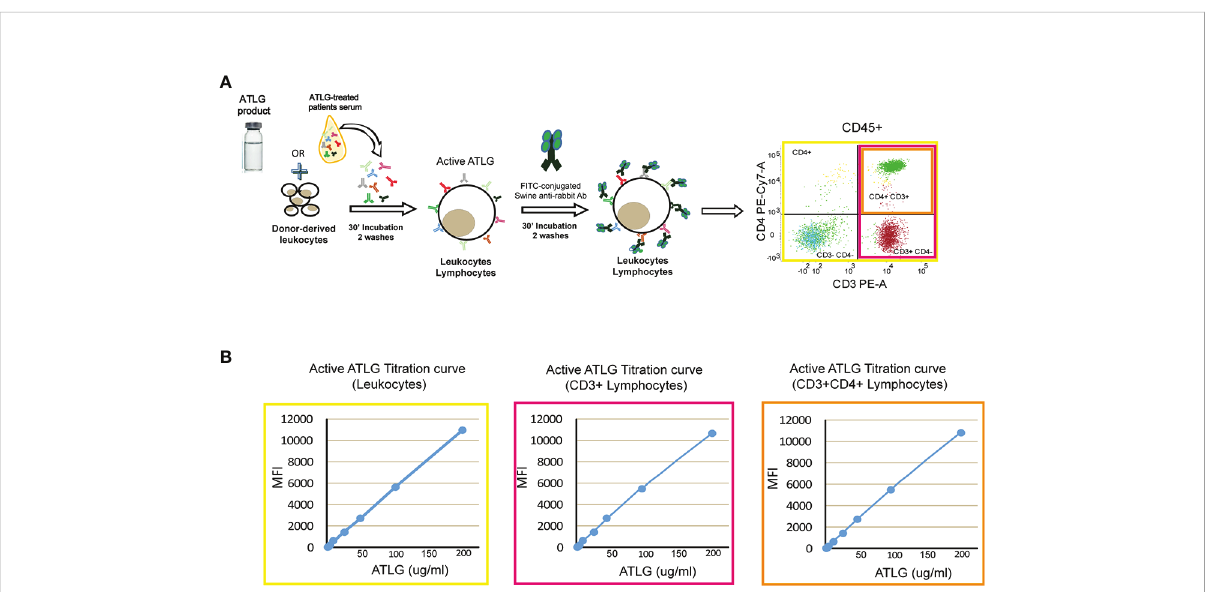
FIGURE 1 Active ATLG binding assay. (A) Schematic representation of fl ow cytometry analysis to measure active ATLG. Serum from ATLG-treated patients is incubated with healthy donor-derived leukocytes. Active ATLG is detected by FITC-conjugated swine anti-rabbit antibody on CD45+ cells, CD3+, and CD3+/CD4+ lymphocytes. (B) Calibration curve [mean fl uorescent intensity vs. ATLG concentration, ( m g/ml)] on CD45+ cells, CD3+ and CD3+/CD4+